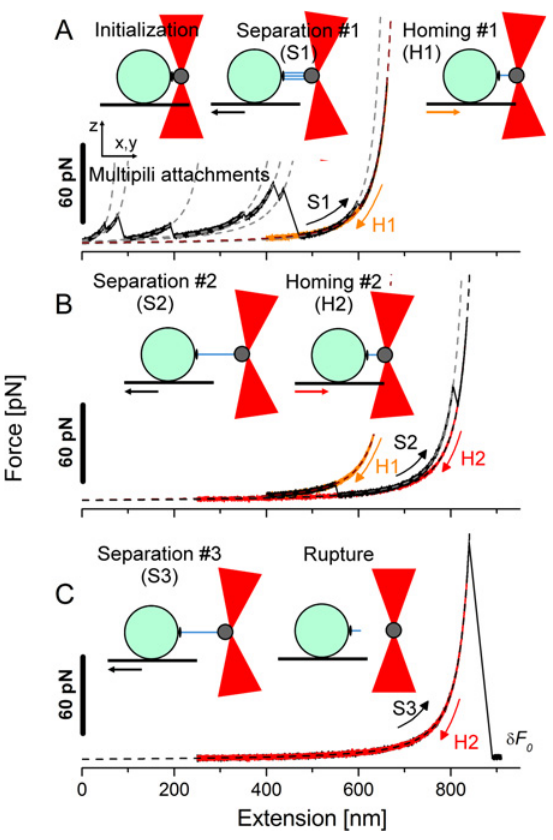
Fig 4. Force spectra from extension/retraction cycles experiments. Typical force spectra experiment at constant velocity on the Pil strain under conditions of 1.5 μ M BSA. The steps were organized as follows: (A) the initialization, separation and homing steps giving the extension (S1) and retraction (H1) traces; (B) second separation/homing cycle with S2 and H2 and (C) third separation until rupture with S3 where the force finally dropped down to the zero force offset ( δ F 0